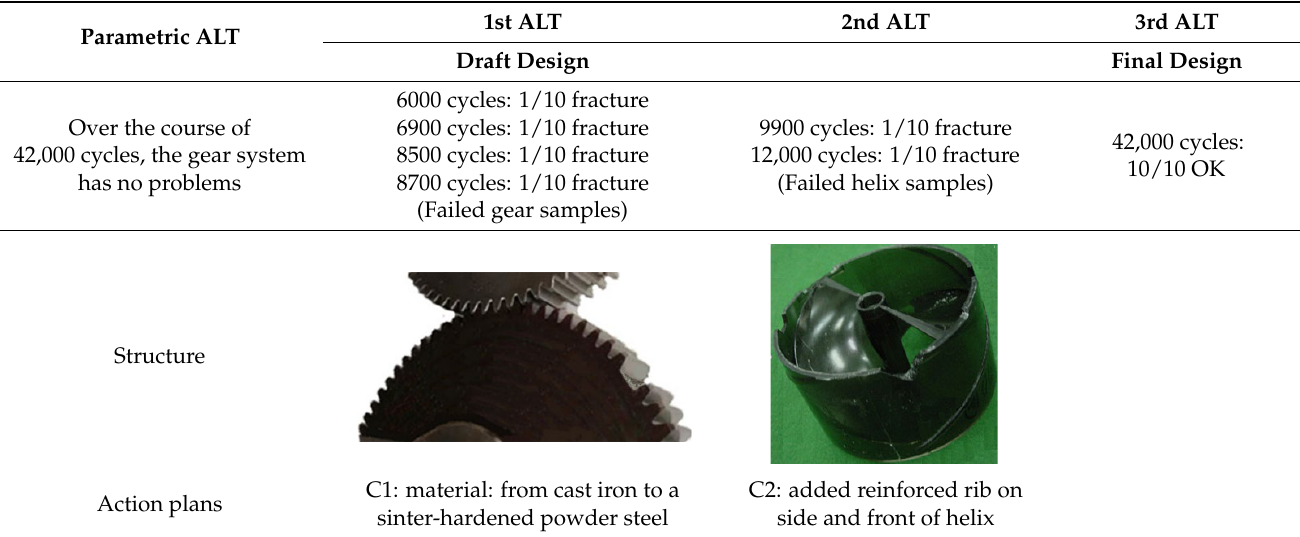
Figure 14. Unsuccessful products after the 2nd ALT: ( a ) unsuccessful products in the 2nd ALT, ( b ) the root cause of 2nd ALT failure.